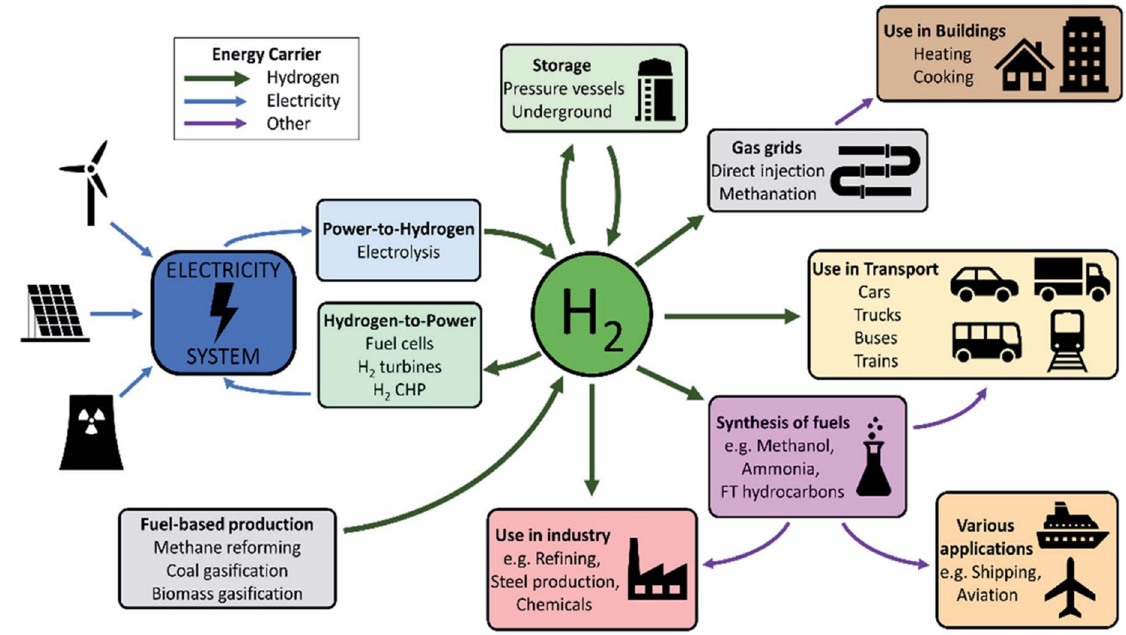
Figure 2. A summary of hydrogen applications [30].